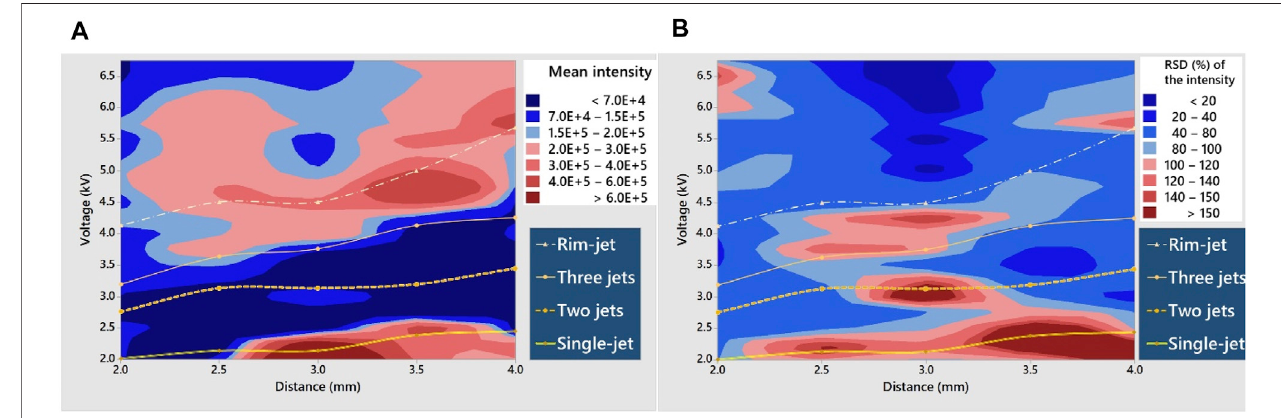
FIGURE6| Contourplotsofthe (A) PSIMSsignalintensityand (B) itsRSDof50 μ g/mltrimethoprimatasolvent fl owrateof50 μ L/minwithvariouscombinationsof the applied voltage and the distance between the paper tip and the MS inlet. The lines indicate the average onset voltages of different spray